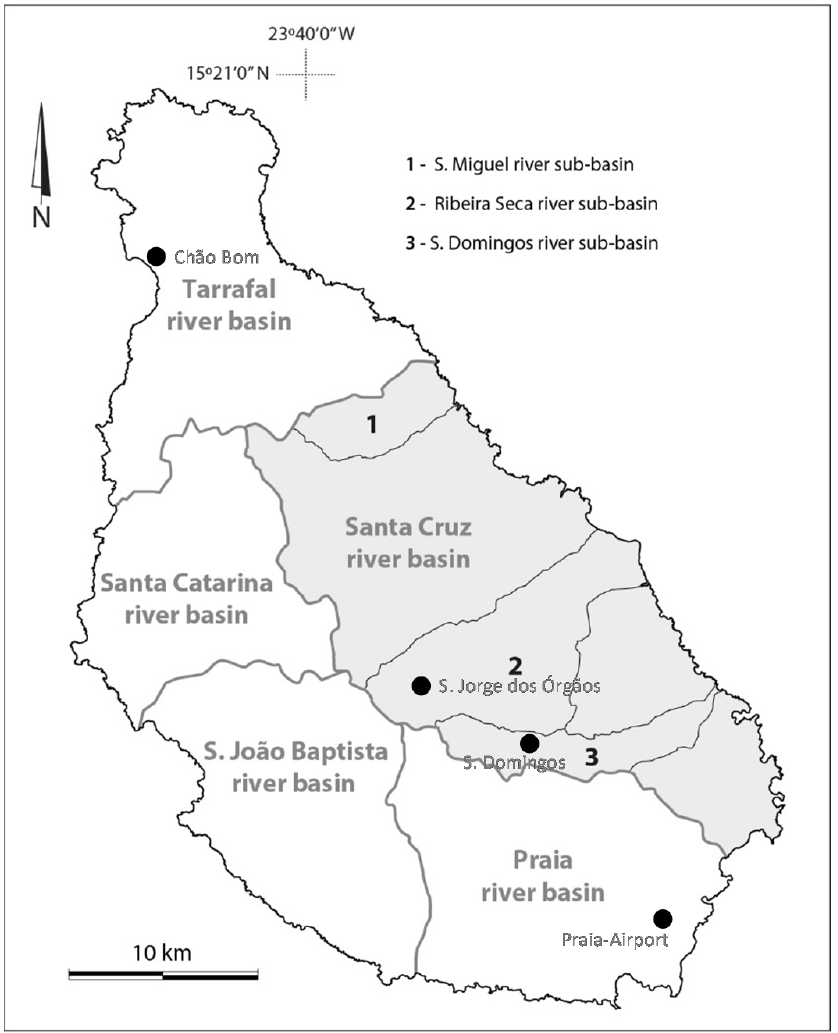
Figure 7. River basins and the most important sub-basins (main agricultural valleys) of Santiago Island (adapted from [24,29]). • Indicates the location of the meteorological stations with complete series in the island. Table 2. The main river basins of Santiago Island total area and precipitation volumes (adapted from [29]. Basin Area Precipitation Total Volume (hm 3 ) River Basin (km 2 ) Tarrafal 188 45 Santa Cruz 355 121 128 62 155 47 179 33